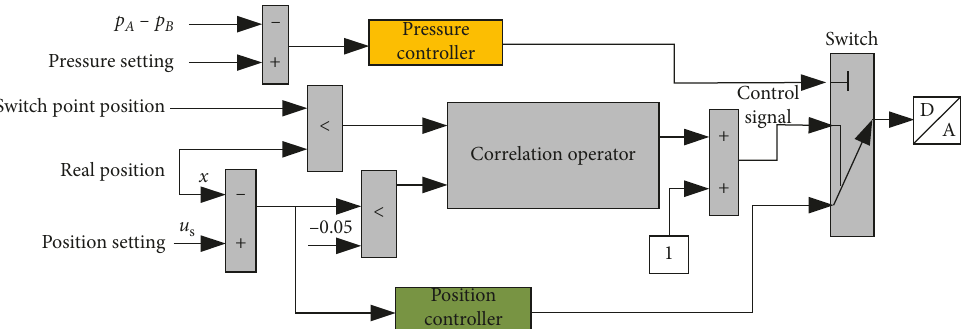
Figure 5: Schematic of parallel pressure and position control.